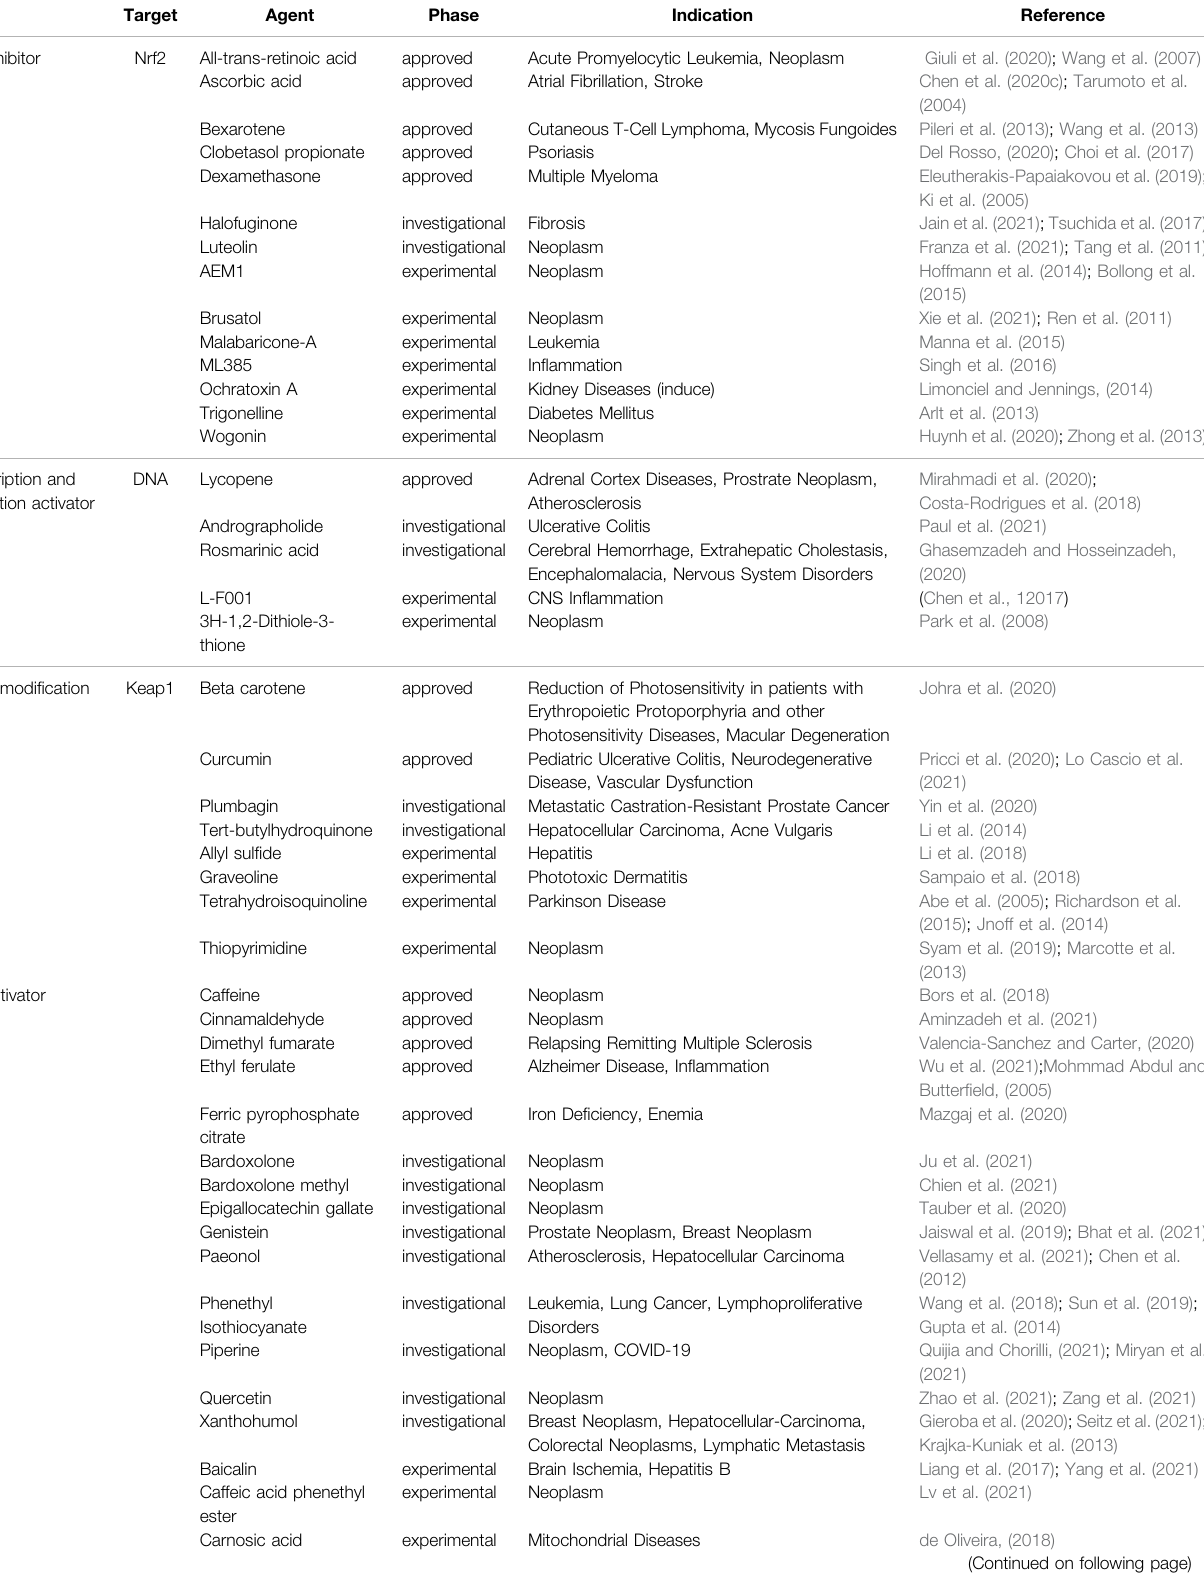
TABLE 4 | Targets in and inhibitor targeting the Keap1-Nrf2-ARE